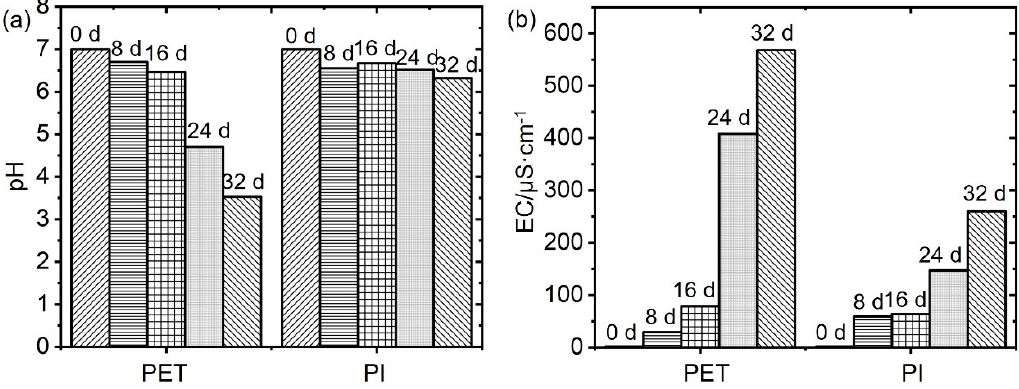
Figure 7. Influence of hydrothermal aging time on pH ( a ) and electronic conductivity ( b ) of immersion solutions of PET and PI films.